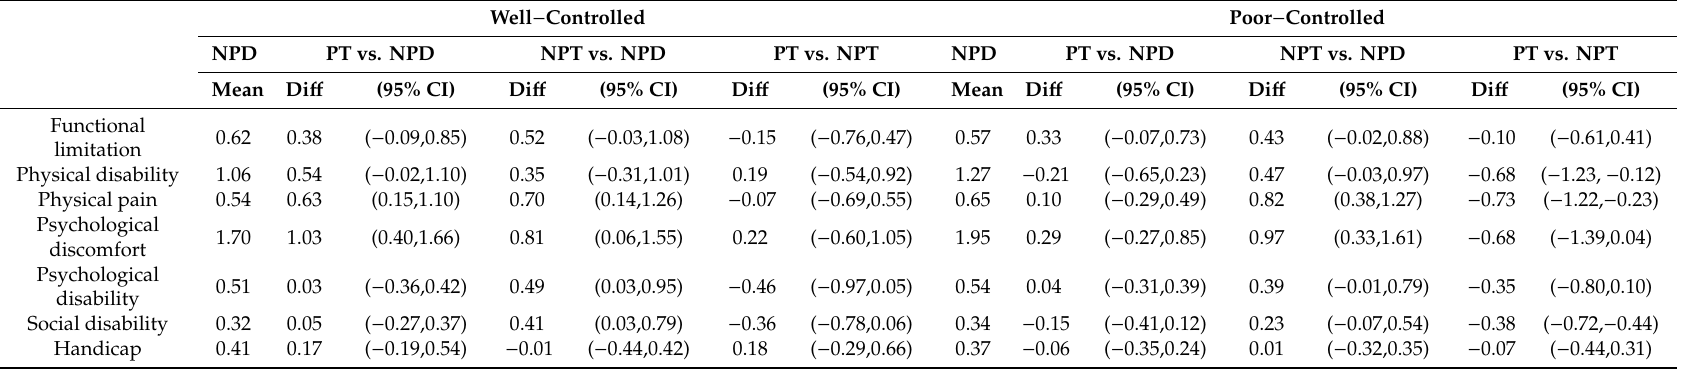
Table 4. Multivariate-adjusted means and di ff erences in scores in the seven Oral Health Impact Profile-14 domains in periodontal treatment groups stratified by glycemic control